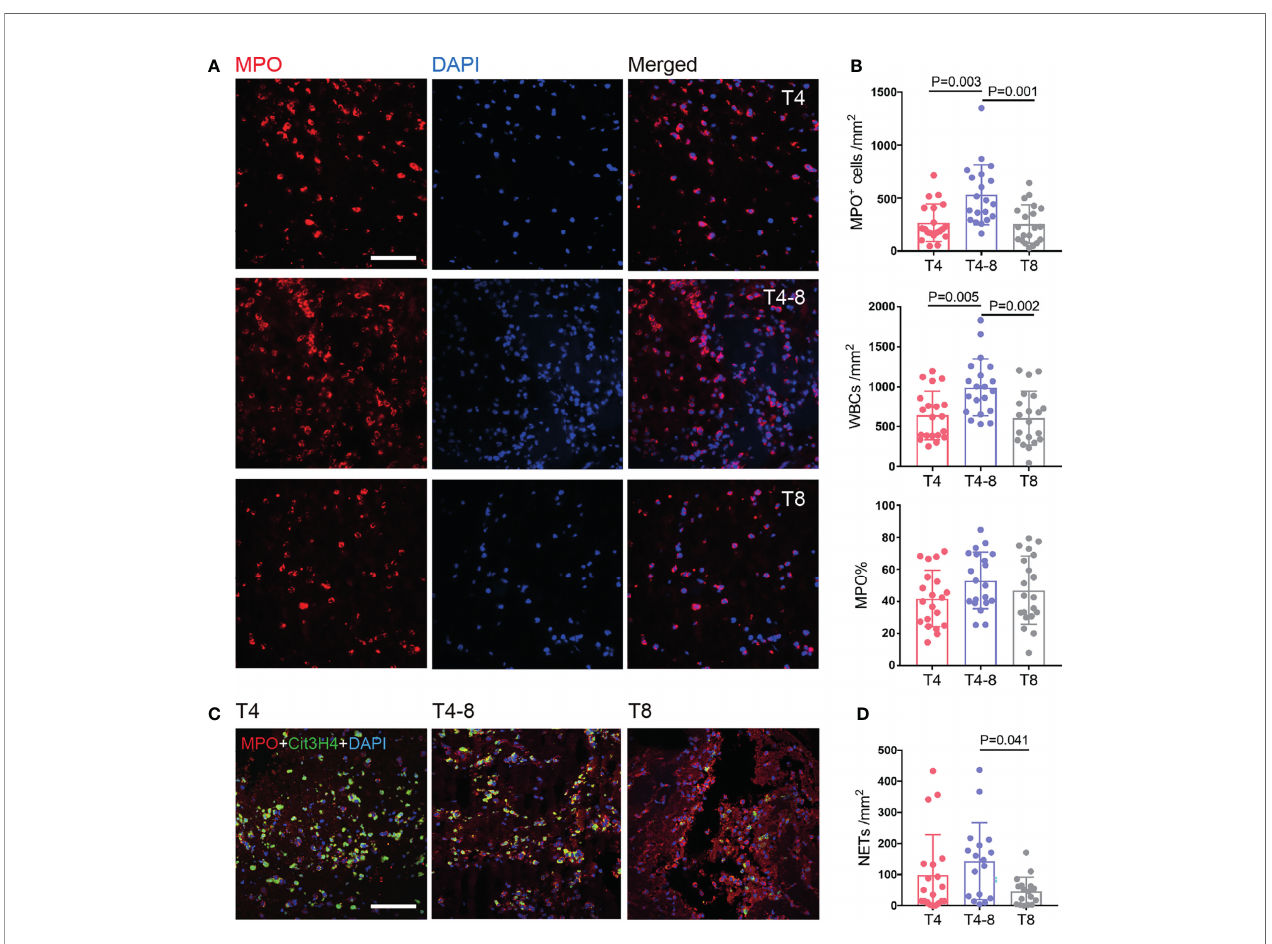
FIGURE 2 | Neutrophil and NET changes in thrombi at different times after reperfusion. (A) Representative immunohistochemical illustration of neutrophils (MPO, red) in thrombi of the T4, T4 – 8, and T8 groups. The nuclei are counterstained with DAPI. Scale bar = 50 m m. (B) Quanti fi cation of MPO+ cells/mm 2 (top), white blood cells/mm 2 (middle), and MPO% (bottom) in thrombi according to different times to reperfusion. N = 20/group. (C) Representative immunohistochemical illustration of NETs in thrombi by staining for MPO (red) and Cit3H4 (green). The nuclei are counterstained with DAPI. Scale bar = 50 m m. (D) Quanti fi cation of NETs/ mm 2 in thrombi according to time to reperfusion. T4, n = 20; T4 – 8, n = 17; T8, n = 17. NETs, neutrophil extracellular